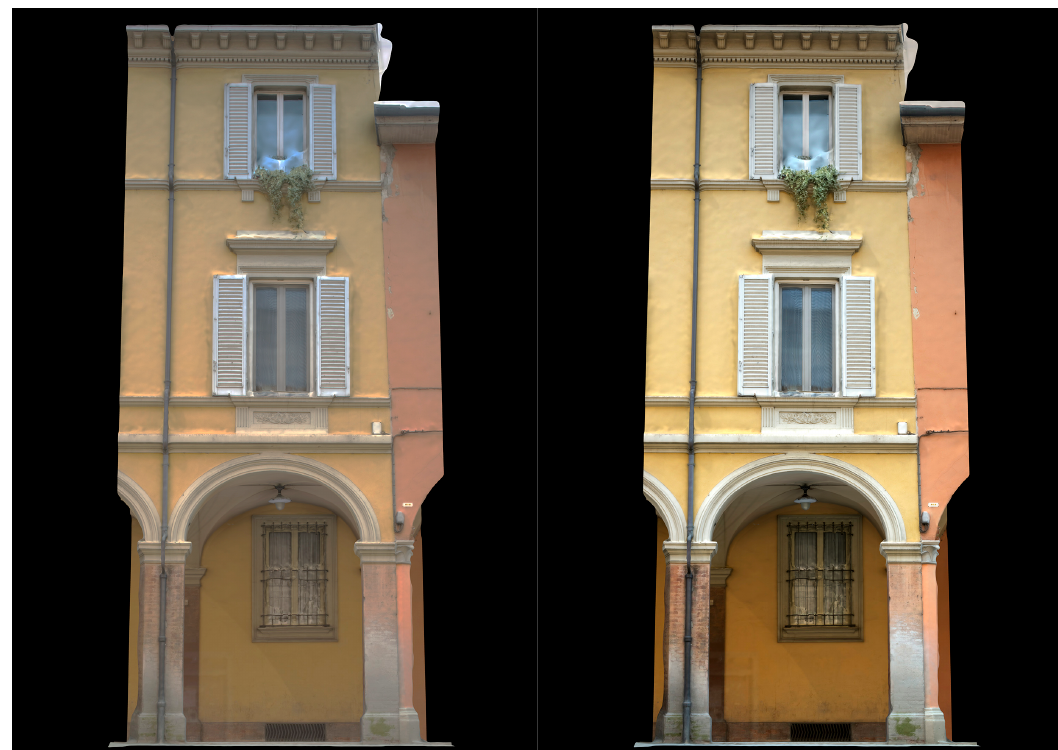
Figure 11. Bologna, building with portico: comparison between the textured 3D model without ( left ) and with color correction ( right ).